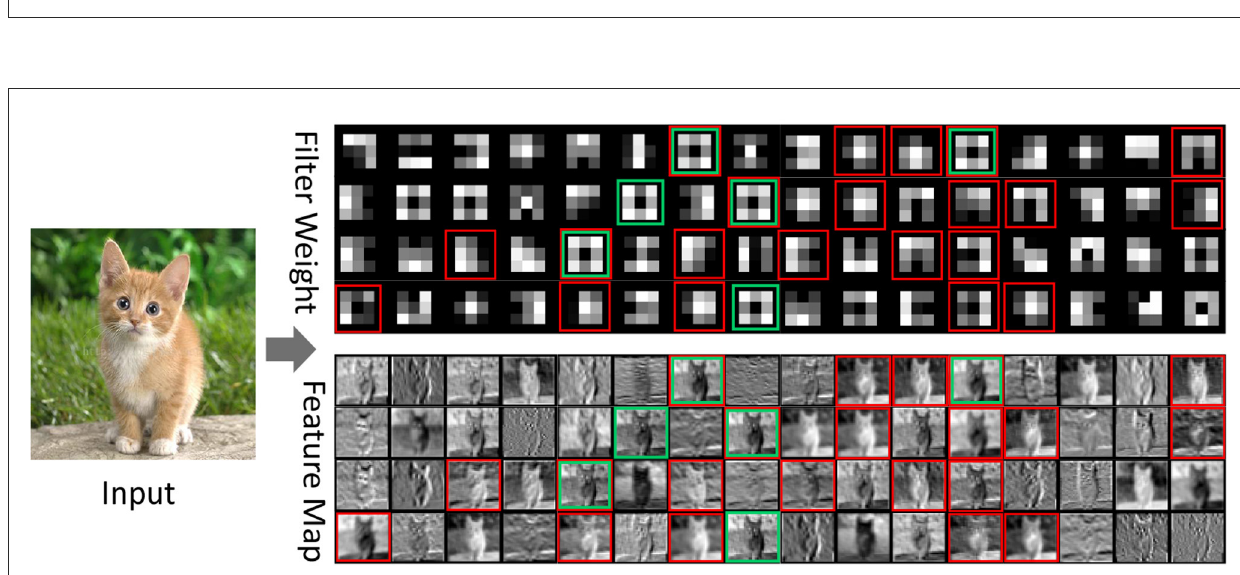
FIGURE4 (A) The pruning rate of each convolutional layer with different values of α for the VGG16 on the CIFAR100 datasets at r different layers with different values of r when α 1. (C, D) The pruning process of the VGG16 on the CIFAR10/100 datasets when rate FLOPs is set to = 0.8 and 0.6, respectively. On CIFAR10, the algorithm meets the pruning requirement after 10 iterations, while CIFAR100 exceeds 6 iterations. The pruning rate of each layer and the change process of rate FLOPs and rate params are also shown in the figure.